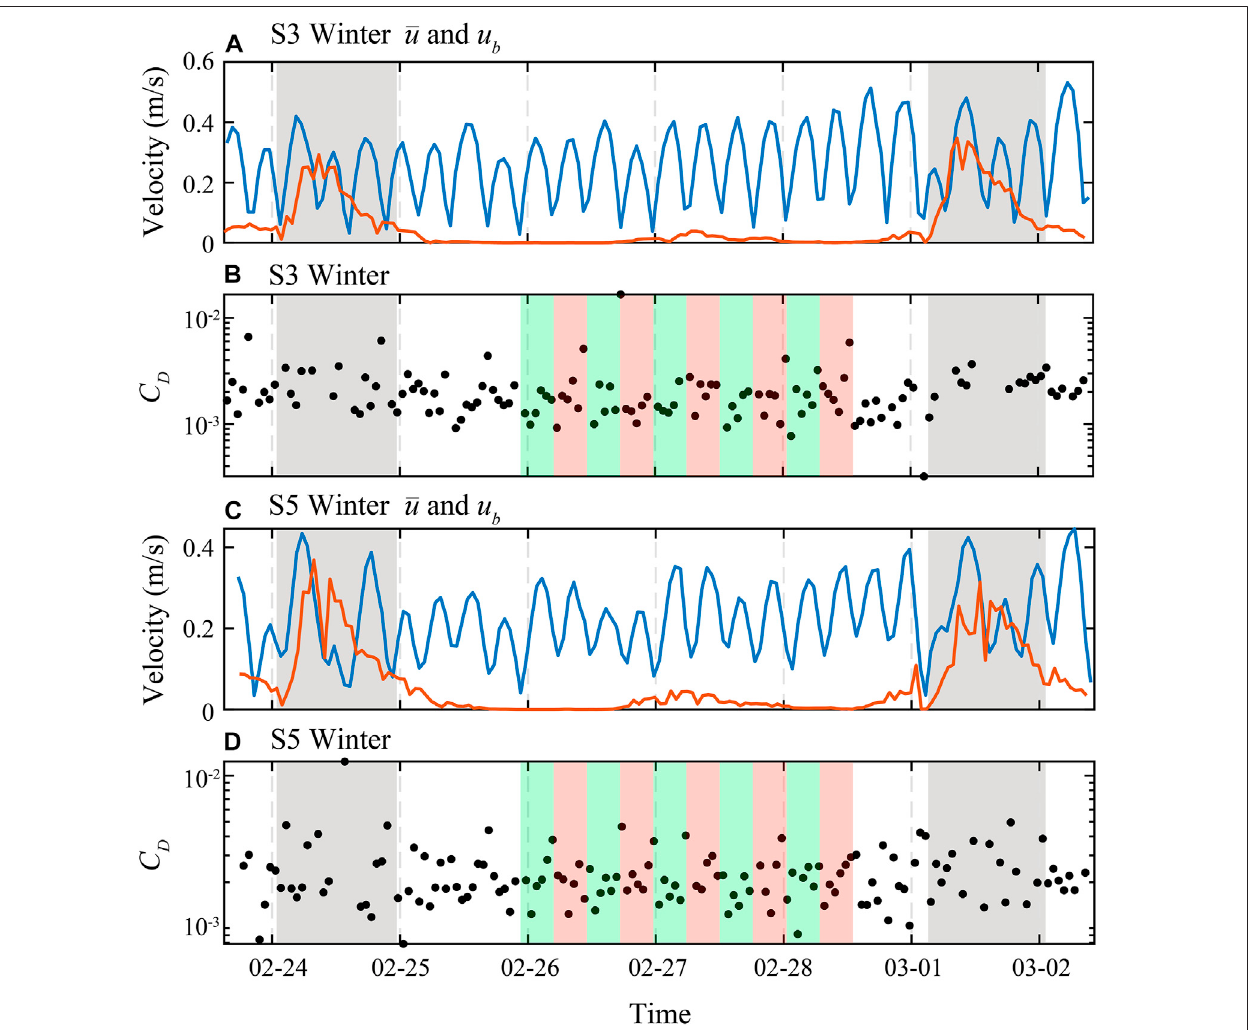
FIGURE7| Time series of (A,C) ADV ’ sburstmean velocity( (cid:1) u , blueline)and bottomwaveorbitalvelocity ( u b ,orangeline) and (B,D) drag coef fi cient, C D ,estimated using ADV ’ sburst meanvelocity at S3and S5inwinter. Greenand redshaded areas denoteperiods ofebb and fl oodtides,respectively,and grayshaded areasdenote periods of strong